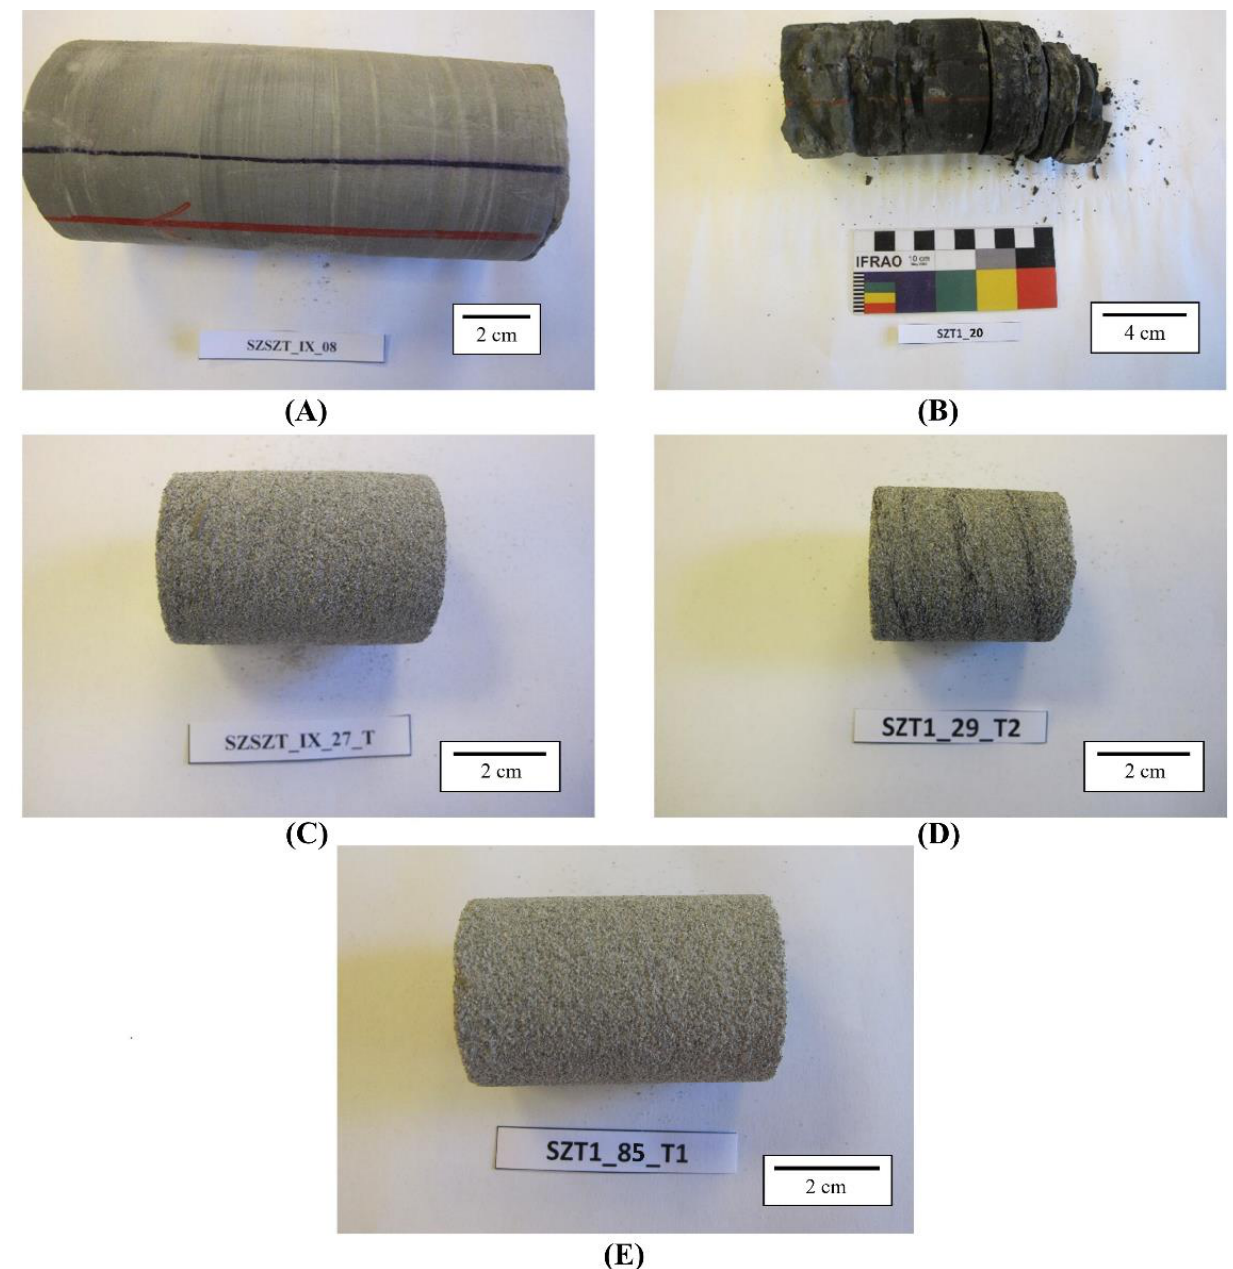
Figure 7. Sedimentary structures identified in the core samples. ( A ) SZSZT_IX_08: Horizontal and of very fine sandy siltstone; ( B ) SZT1_20: Horizontal bedded coaly argillaceous marl and clayey coal; ( C ) SZSZT_IX_27_T: Structureless fine-medium grained sandstone with clay intraclasts; ( D ) SZT1_29_T2: Coalified plant fragment laminae in fine-medium grained sandstone according to the bedding direction; ( E ) SZT1_85_T1: Structureless medium-coarse grained sandstone.